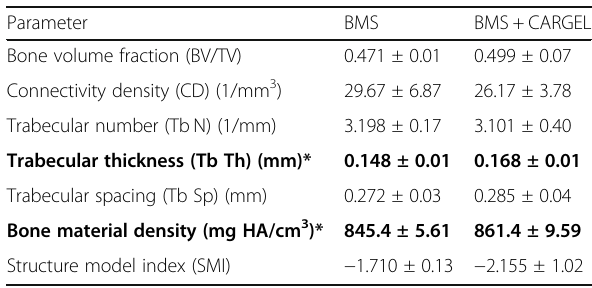
Table 1 μ CT data ± standard deviations. * and bold = parameters with significant differences. BMS = bone marrow